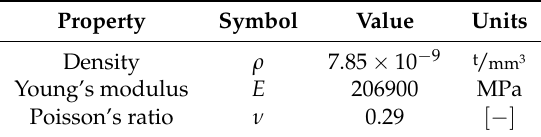
Figure 8. Geometry of the gear housing with design domain shown in blue. Table 2. Linear-elastic material properties of steel.